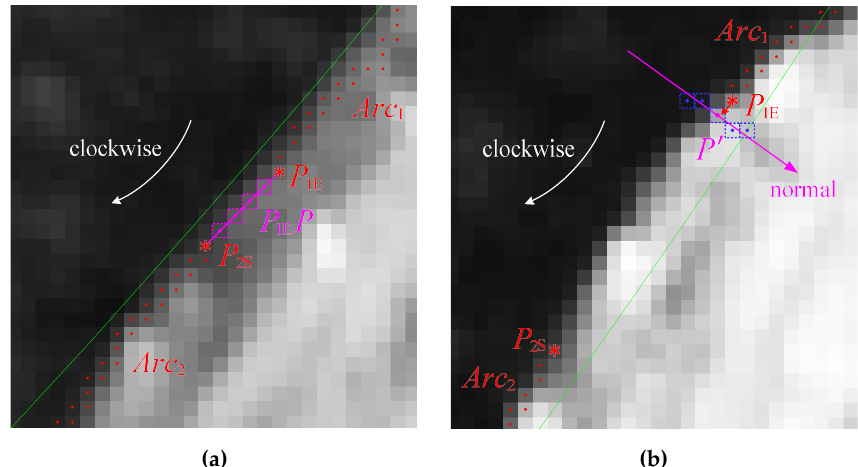
Figure 5. Arc-based edge connection, in which red dots are clockwise organized edge points to be connected, red asterisks denote arc endpoints, and green line denotes the fitted circular contour C ck . ( a ) Direct connection with connecting line P 1E P 2S ; ( b ) PSC method, in which red arrow shows the tangential direction of C ck at P 1E , P (cid:48) denotes the prediction point, magenta arrow shows the normal direction of C ck at P (cid:48) , and blue boxes indicate the search range for gradient calculation. As shown in Figure 5a, red dots are edge points to be connected, green line denotes fitted circular contour (cid:1829) (cid:3030)(cid:3038) , and direct connection is first tried through creating a connecting line (cid:1842) (cid:2869)(cid:2889) (cid:1842) (cid:2870)(cid:2903) . Then